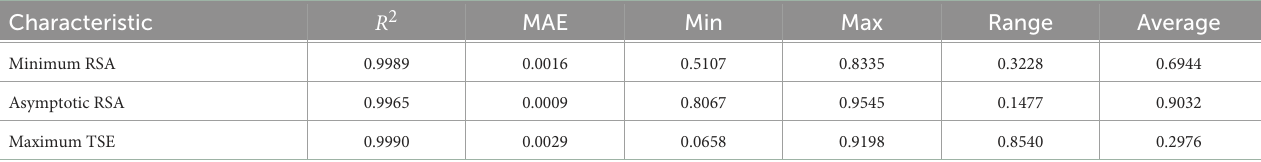
TABLE 2 Performances of the neural networks for specific characteristics during post-burn healing.